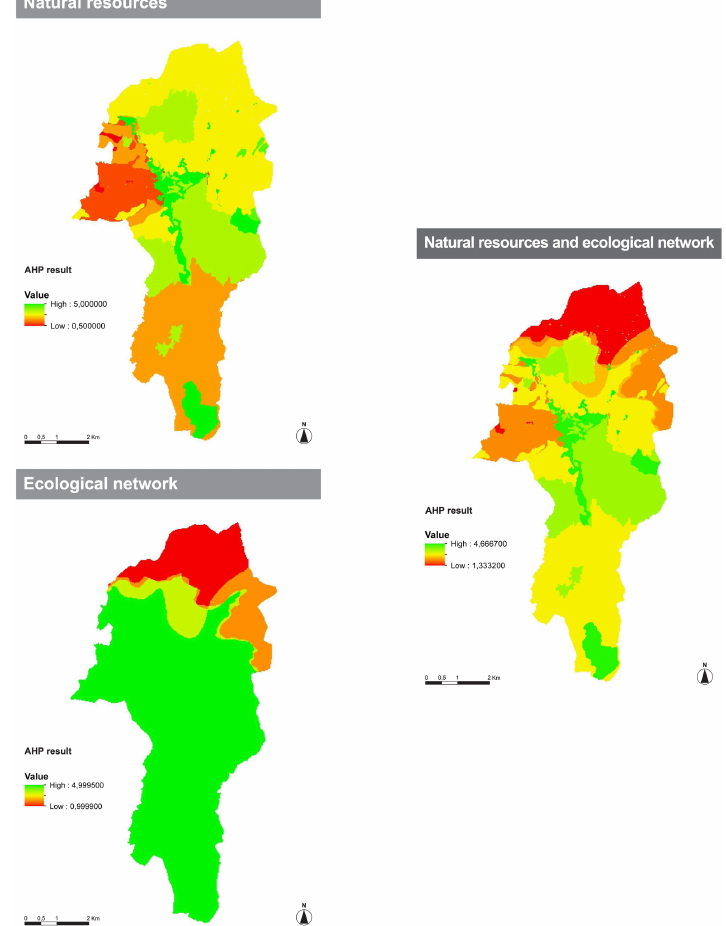
Fig. 5. Urbanization suitability maps: natural resources and ecological